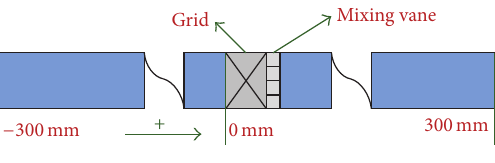
Figure 26: Simulation